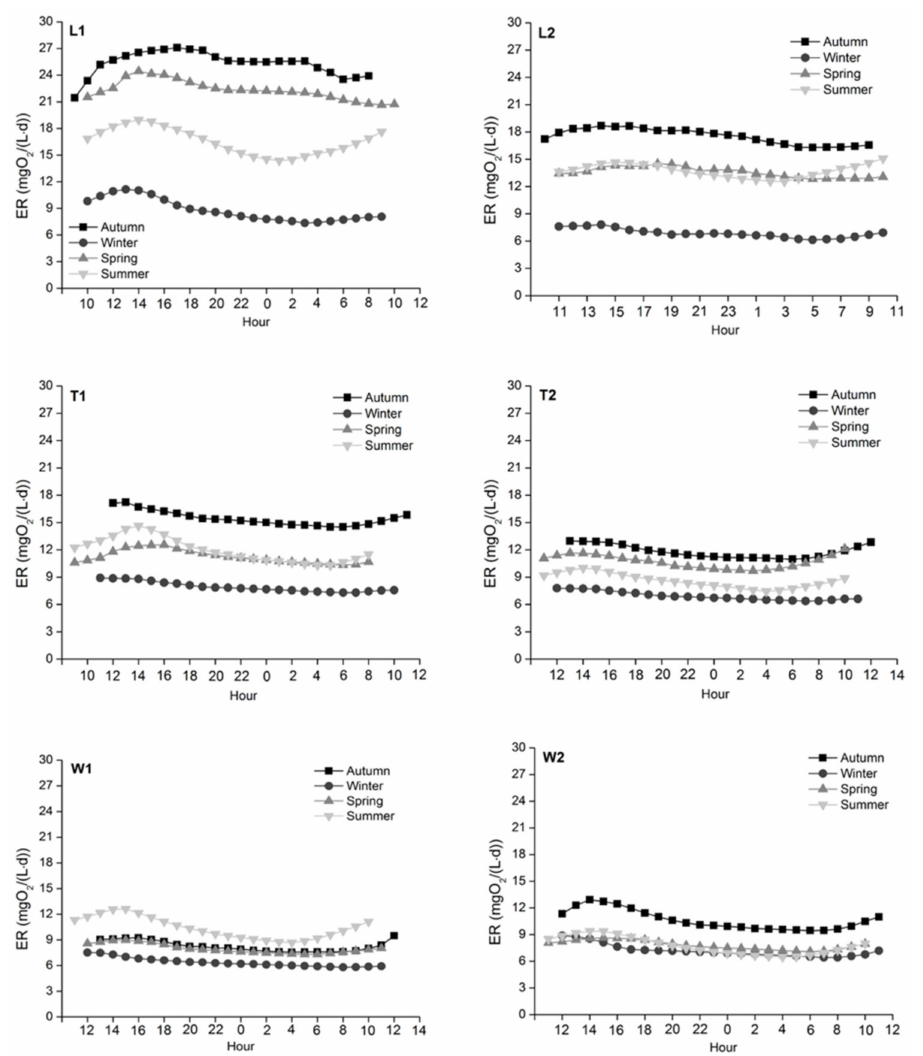
Figure 7. Diurnal variations of ER in the four seasons across study sites. ER was the lowest in winter and the highest in autumn across study sites except W1. Significant seasonal variations of ER at all sites were recorded from autumn to